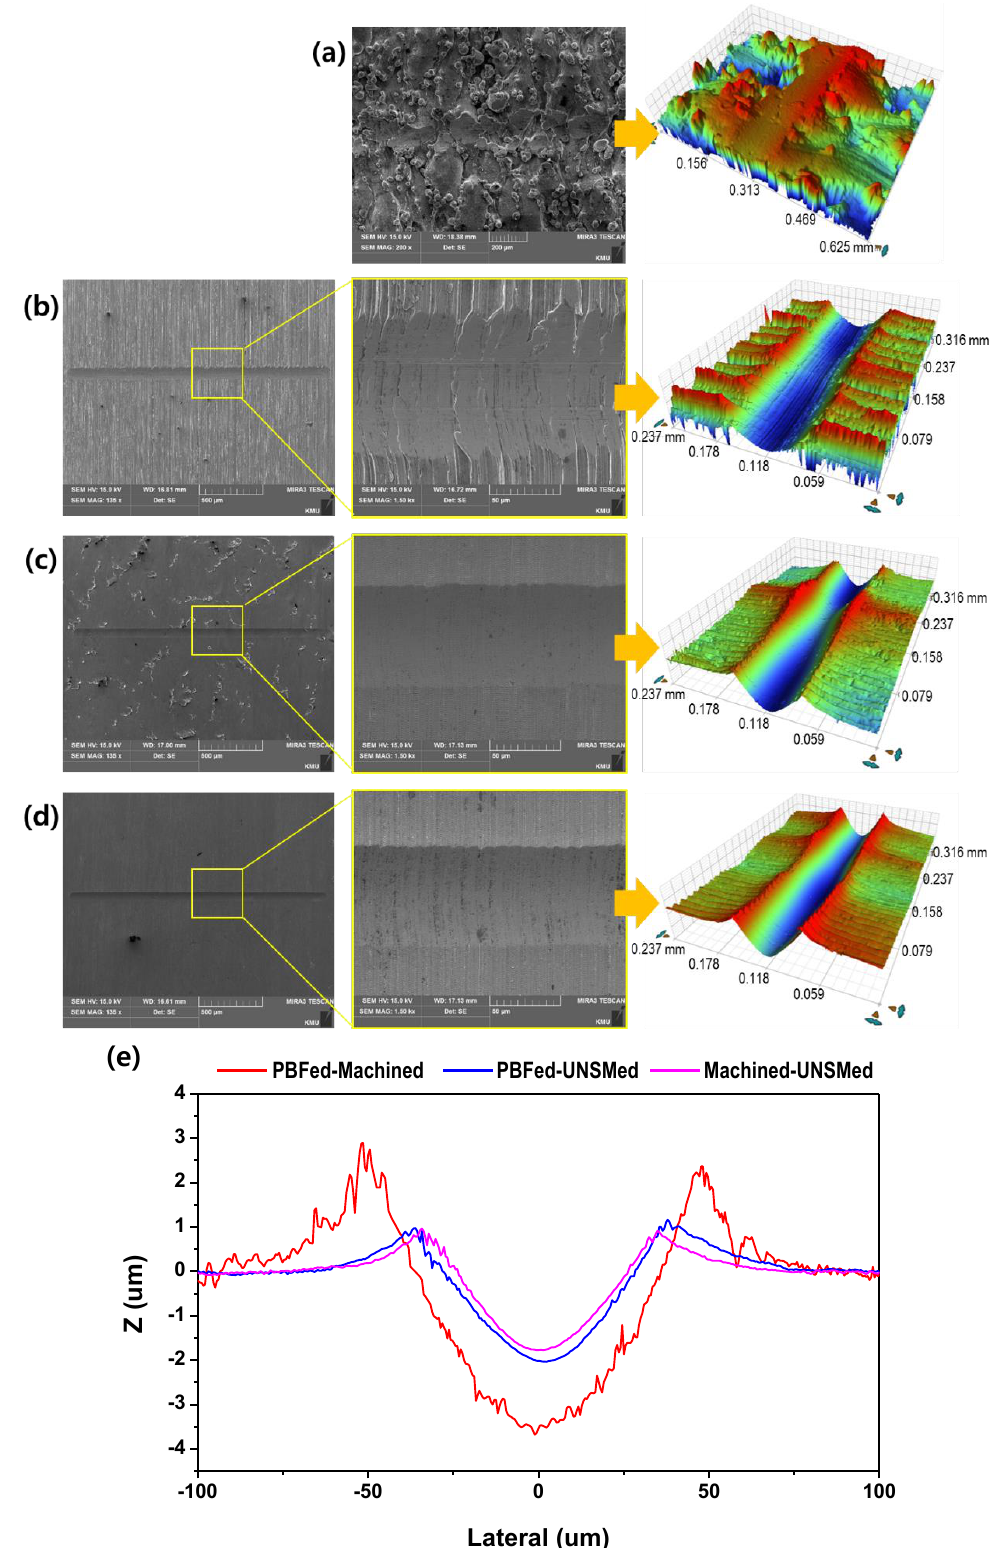
Figure 13. SEM images and 2D/3D groove shapes after scratch test: ( a ) as-built (PBF), ( b ) PBFed-machined, ( c ) PBFed-UNSMed, ( d ) machined-UNSMed, and ( e ) 2D profiles of the scratched grooves.